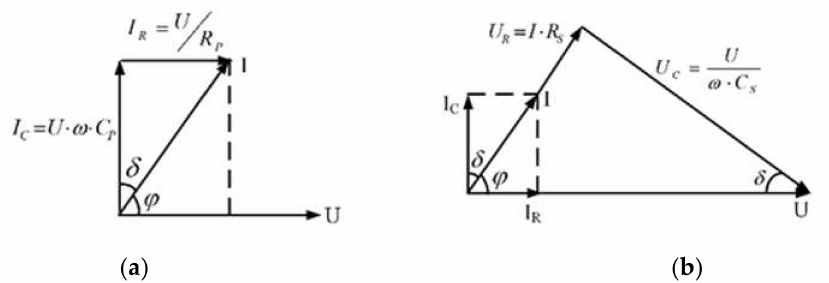
Figure 3. Phasor diagrams of dielectric material: ( a ) parallel and ( b ) series.